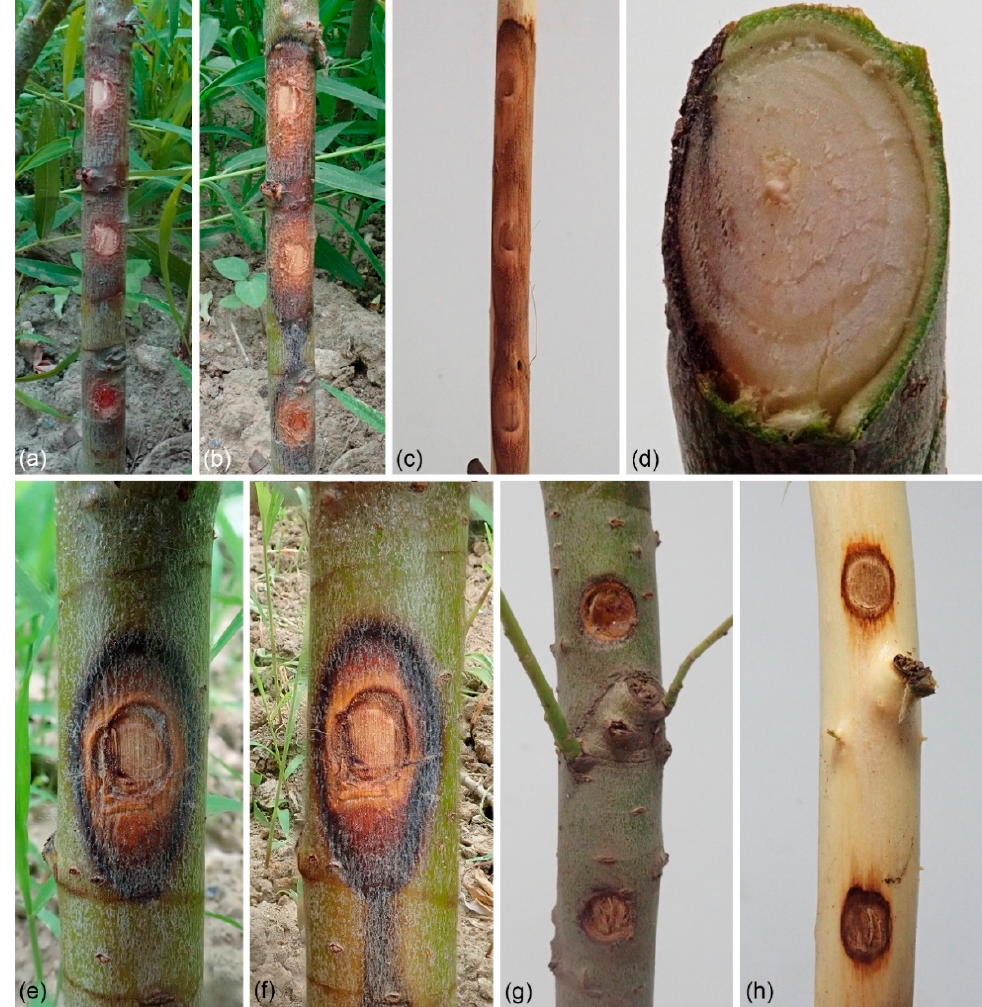
Figure 5. Stem blight symptoms on Salix matsudana caused by Cytospora species: ( a – d ) stem blight symptoms on Salix matsudana caused by Cytospora alba (CFCC 55462). Symptoms after ( a ) one week and ( b ) two weeks. ( c ) Resinous canker formed after inoculation with C. alba . ( d ) Longitudinal section through pathogenic site. ( e , f ) Stem blight symptoms on Salix matsudana caused by Cytospora paracinnamomea (CFCC 55453). Symptoms after ( e ) one week and ( f ) two weeks. ( g , h ) Blank control group, no symptoms on Salix matsudana twigs after three weeks of inoculation with agar block.